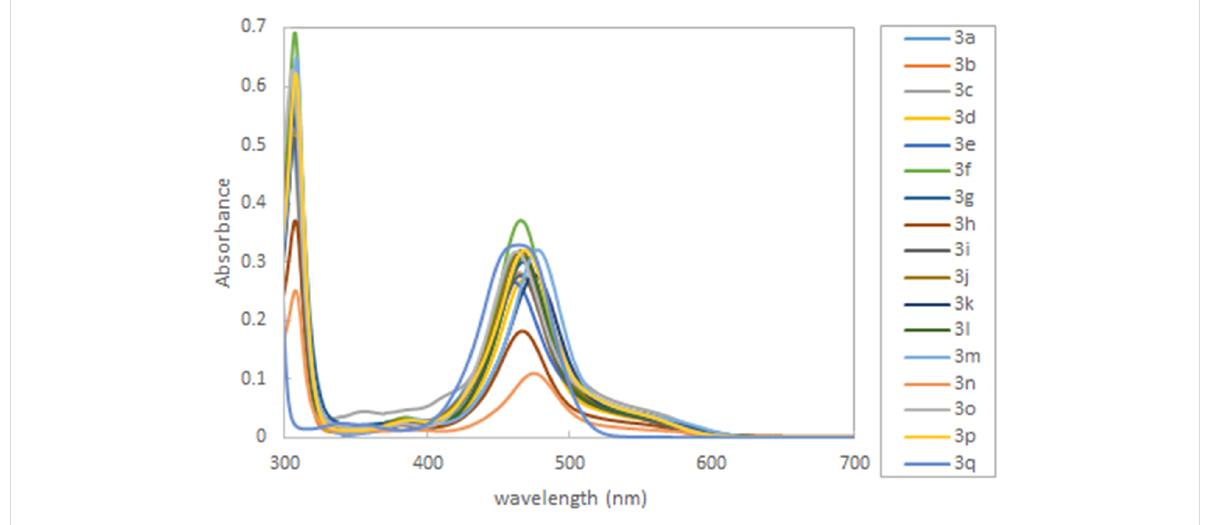
Figure 2: The UV–vis spectra of thioxanthylium salt (0.1 mM) in CH 3 CN.